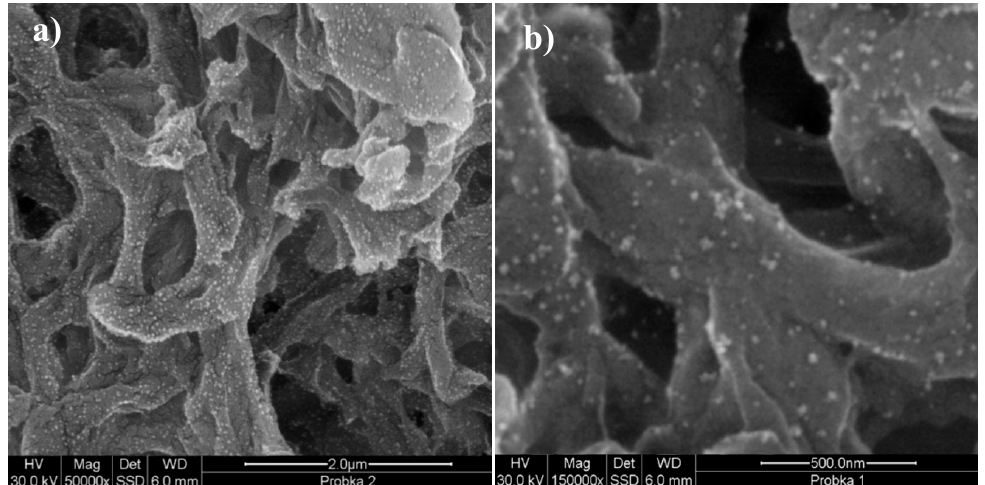
Figure 3. View of nanoparticles of gold colloids ( a ) and silver ( b ) after fractionation and placement on a nylon diaphragm (Supelco, Park Bellefonte, PA, USA) made with a help of FEI Quanta 200 FEG scanning electron microscope. The magnification applied to the observed colloidal gold and silver 50,000 ( a ) and 150,000 ( b ) times, respectively.